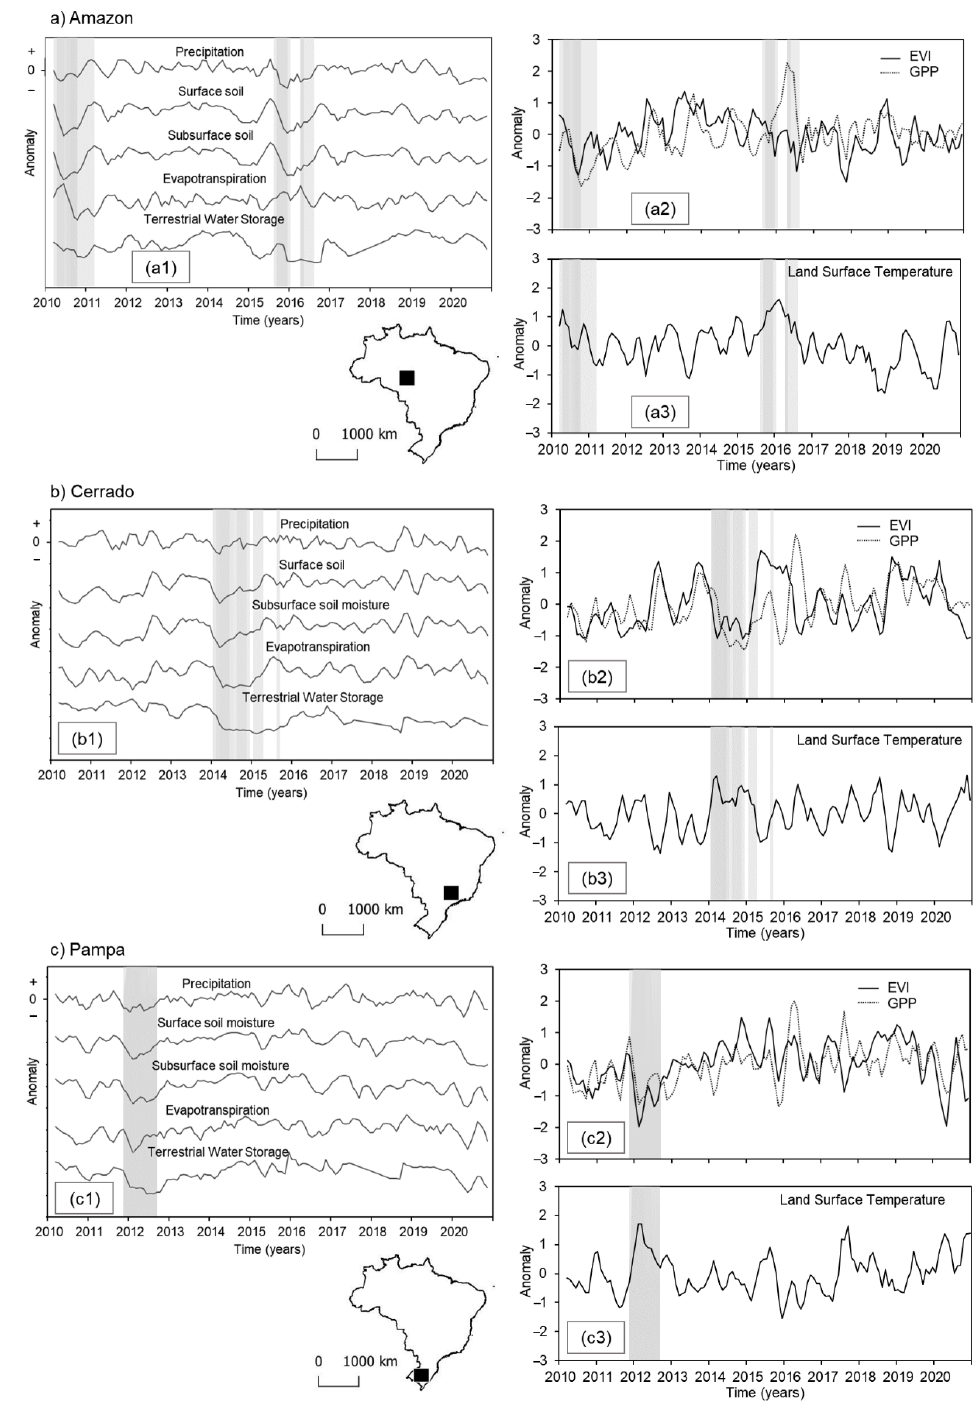
Figure 4. Temporal drought patterns (2010 to 2020) for analyzed variables in the three Brazilian study areas: ( a ) the Amazon, ( b ) Cerrado and ( c ) Pampa; being ( a1 ), ( b1 ), and ( c1 ) for P , SM, SSM , ET , and TWSA ; ( a2 ), ( b2 ), ( c2 ) for EVI and GPP ; and ( a3 ), ( b3 ), and ( c3 ) for LST . The hatched area represents z-score ≤ − 0.5 verified in dry periods with long effect in the analyzed variables (approximately 2010 and 2015 for the Amazon, 2014 for the Cerrado, and 2012 for the Pampa).